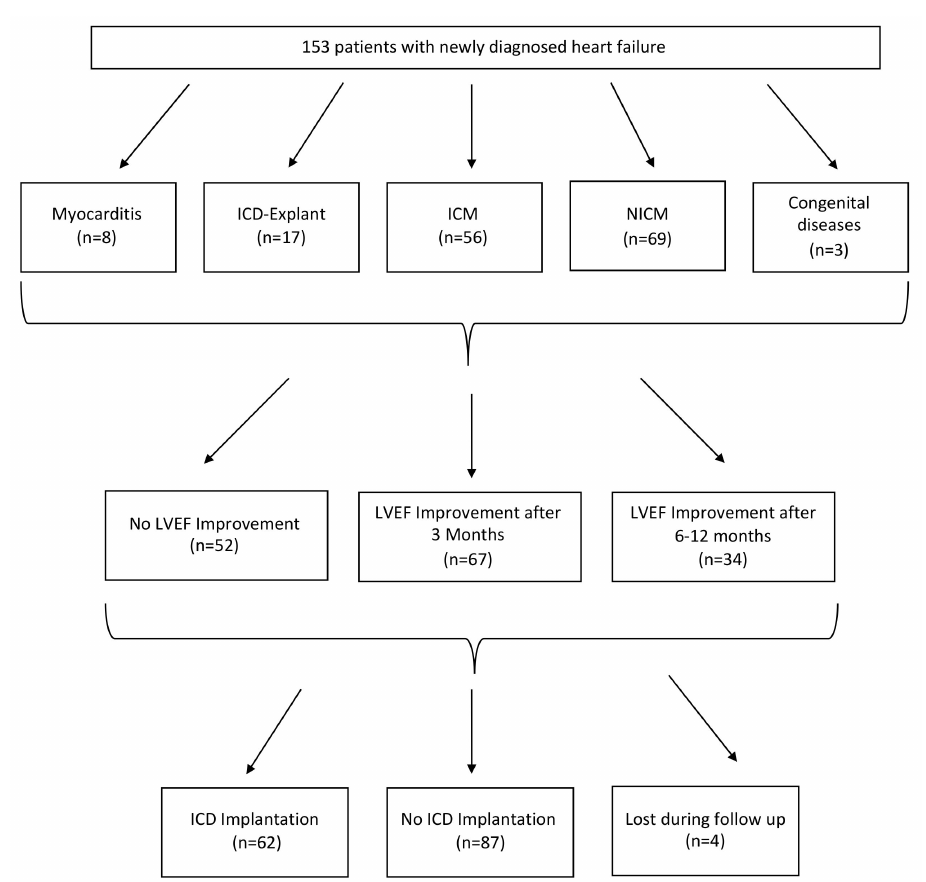
Figure 2. Study flow chart. ICD: implantable cardioverter defibrillator; ICM: ischemic cardiomyopathy; NICM: non-ischemic cardiomyopathy; LVEF: Left ventricular ejection